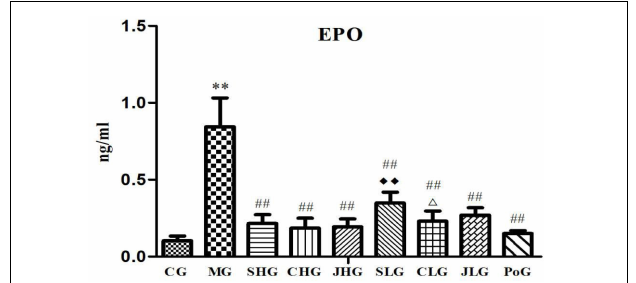
FIGURE 2 | Effect of serum indexes of Epo for various groups of animals. CG, control group, MG, model group, SHG, Curcumae Longae Radix group, CHG, Stir-frying Curcumae Longae Radix with vinegar group, JHG, Stir-frying Curcumae Longae Radix with wine group, SLG, Curcuma phaeocaulis Radix group, CLG, Stir-frying Curcuma phaeocaulis Radix with vinegar group, JLG, Stir-frying Curcuma phaeocaulis Radix with wine group and PoG, positive group. Values were mean ± SD ( n = 6). ∗ p < 0.05 and ∗∗ p < 0.01 vs. control group; # p < 0.05 and ## p < 0.01 vs. model group; (cid:49) p < 0.05 and (cid:49)(cid:49) P < 0.01 vs. Curcumae Longae Radix group; (cid:7) P < 0.05 and (cid:7)(cid:7) P < 0.01 Curcuma phaeocaulis Radix group versus Curcumae Longae Radix group, Stir-frying Curcuma phaeocaulis Radix with vinegar group versus Stir-frying Curcumae Longae Radix with vinegar group, Stir-frying Curcuma phaeocaulis Radix with wine group versus Stir-frying Curcumae Longae Radix with wine